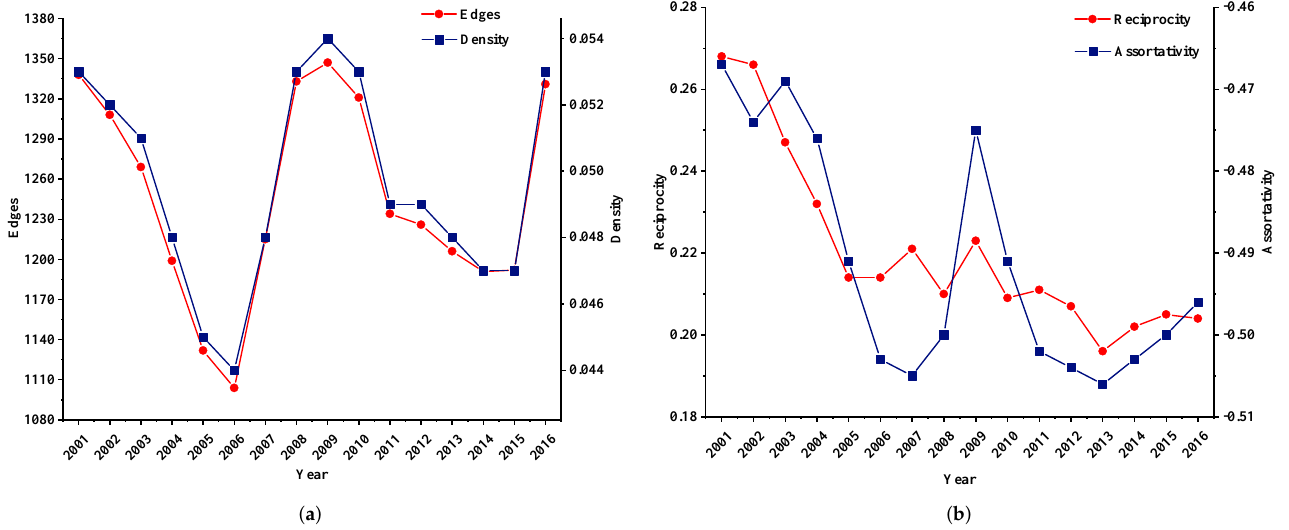
Figure 2. ( a ) Evolutionary trends in the number of edges and the density of VWSR transfer networks. ( b ) The trend of network reciprocity and